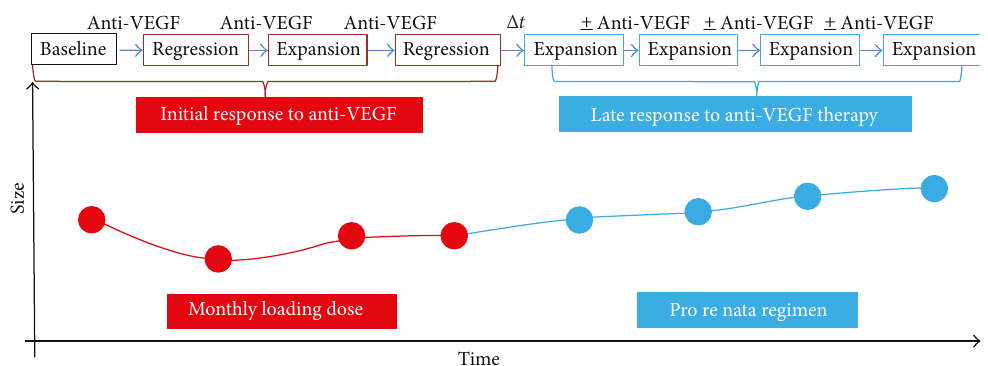
Figure 4: Illustrative drawing of suggested types of response to antiangiogenic treatment in CNV associated to neovascular AMD. Treatment- naïve, immature CNV, undergoing monthly loading phase, is depicted in red. Previously treated CNV, undergoing PRN, is depicted in blue. In the treatment-naïve eyes, there will be an initial response to treatment, characterized by regression (contraction) of the lesion area after each intravitreal injection (red dots). This initial response to anti-VEGF may be replaced after a variable amount of time( Δ t ) in an as needed protocol (PRN) by a late response in which, despite the disappearance of exudative signs of CNV, their area will continue to expand (blue dots). The latter type of response corresponds to a mature